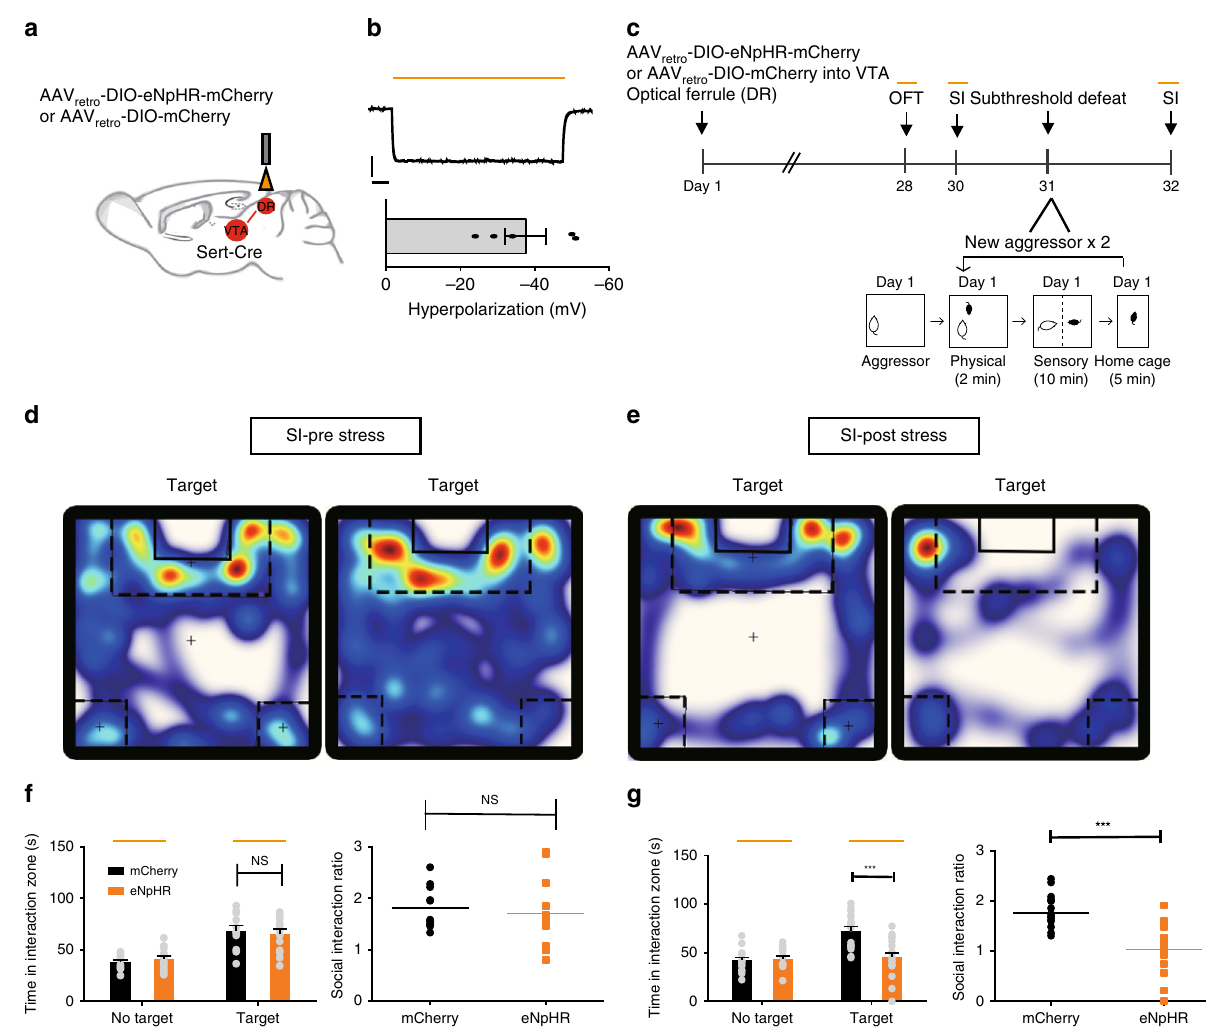
Fig. 5 Silencing of 5-HT DR → VTA neurons promotes stress susceptibility. a Experimental setup for the expression of AAV retro -DIO-eNpHR-mCherry or control virus (mCherry) in 5-HT DR → VTA neurons and ferrule implantation into the DR. b Whole-cell current-clamp recordings of eNpHR-mCherry neurons in response to 593 nm light (yellow lines) in DR slices showed that yellow light drove hyperpolarization (top). Summary plot (bottom) showing robust light-evoked hyperpolarization ( n = 5 neurons from two mice). Scale, 20 mV, 1 s. c Experimental timeline of the inhibition of 5-HT DR → VTA neurons (top panel) and a schematic of the subthreshold paradigm (bottom panel). d , e Representative traces of animals expressing eNpHR in 5-HT DR → VTA neurons during the social interaction test with light stimulation ( d ) or after subthreshold defeat stress with optical stimulation ( e ). Warmer colors indicate more time spent. f No signi fi cant difference was observed in social interaction time (eNpHR, n = 13 mice; mCherry, n = 11 mice; one-way ANOVA, F 1,22 = 0.177, P = 0.678) or social interaction ratio during inhibition of 5-HT DR → VTA neurons (eNpHR, n = 13 mice; mCherry, n = 11 mice; one-way ANOVA, F = 1,22 0.220, P = 0.644). g Silencing of 5-HT DR-VTA neurons following subthreshold defeat stress exposure elicits social aversion; (eNpHR, n = 18 mice; mCherry, n = 17 mice; one-way ANOVA, interaction: F = 18.287, P < 0.001, SI ratio: F = 28.155, P < 0.001). Data are represented as mean ± SEM. NS: not 1,33 1,33 statistically signi fi cant; ** P < 0.01, *** P < 0.001. Source data are provided as a Source Data fi